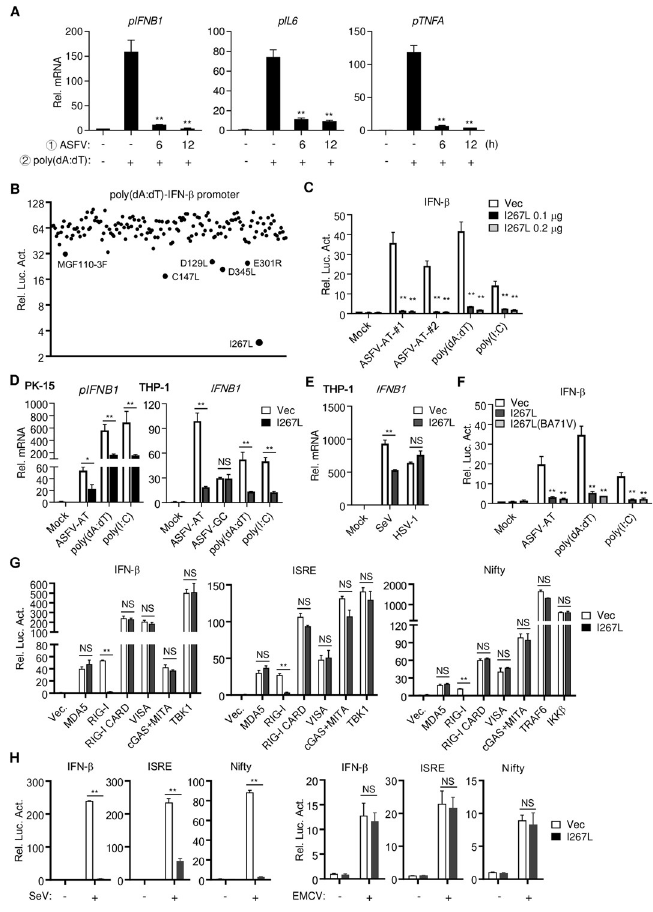
Fig 3. ASFV antagonizes RNA Pol-III-RIG-I axis. ( A ) ASFV infection inhibits poly(dA:dT)-induced transcription of IFNB1 , IL6 and TNFA . PAMs (2 × 10 6 ) were uninfected or infected with ASFV (MOI = 0.1) for the indicated times, and then were stimulated with transfected poly(dA:dT) (1 μ g/ml) for 4 hours before RT-qPCR were performed. ( B ) Screening of ASFV proteins that inhibits poly(dA:dT)-induced activation of the IFN- β promoter. HEK293T cells were transfected with plasmids of individual ASFV cDNA (0.1 μ g), the IFN- β luciferase reporter (0.05 μ g) and TK reporter (0.01 μ g/ml). Twenty-four hours later, cells were left untreated or stimulated with transfected poly(dA:dT) (1 μ g/ml) for 10 hours before luciferase assays were performed. The proteins that showed more than two-fold inhibition are labeled in the figure. ( C ) The effects of I267L on activation of the IFN- β promoter stimulated by transfected ASFV-AT, poly(dA:dT), and poly(I:C) (1 μ g/ml). The experiments were similarly performed as in (B). ( D ) PK-15 and THP-1 cells (1 × 10 6 ) stably transduced with vector or I267L were stimulated with transfected ASFV-AT, poly(dA:dT), and poly(I:C) (1 μ g/ml) for 6 hours before RT-qPCR were performed. ( E ) THP-1(1 × 10 6 ) stably transduced with vector or I267L were infected with SeV or HSV-1 (MOI = 0.1) for 6 hours before qPCR was performed. ( F ) The effects of I267L encoded by ASFV genotype I (Ba71V) and genotype II (CN/GS/2018) on activation of the IFN- β promoter stimulated by transfected ASFV-AT, poly(dA:dT), and poly(I:C) (1 μ g/ml). The experiments were similarly performed as in (B). ( G ) HEK293T cells (1 × 10 5 ) were co-transfected with the indicated reporters, expression plasmids and empty vectors or I267L expression plasmids (0.05 μ g). Luciferase assays were performed 24 hours after transfection. pNifty-luciferase reporter: a reporter to indicate NF- κ B activation, which contains five NF- κ B binding sites. ( H ) HEK293T cells (1 × 10 5 ) were co-transfected with the indicated reporters, empty vectors or I267L expression plasmids (0.05 μ g). Twenty-four hours later, cells were infected with SeV (MOI = 0.1) or EMCV (MOI = 1.0) for 12 hours before luciferase assays were